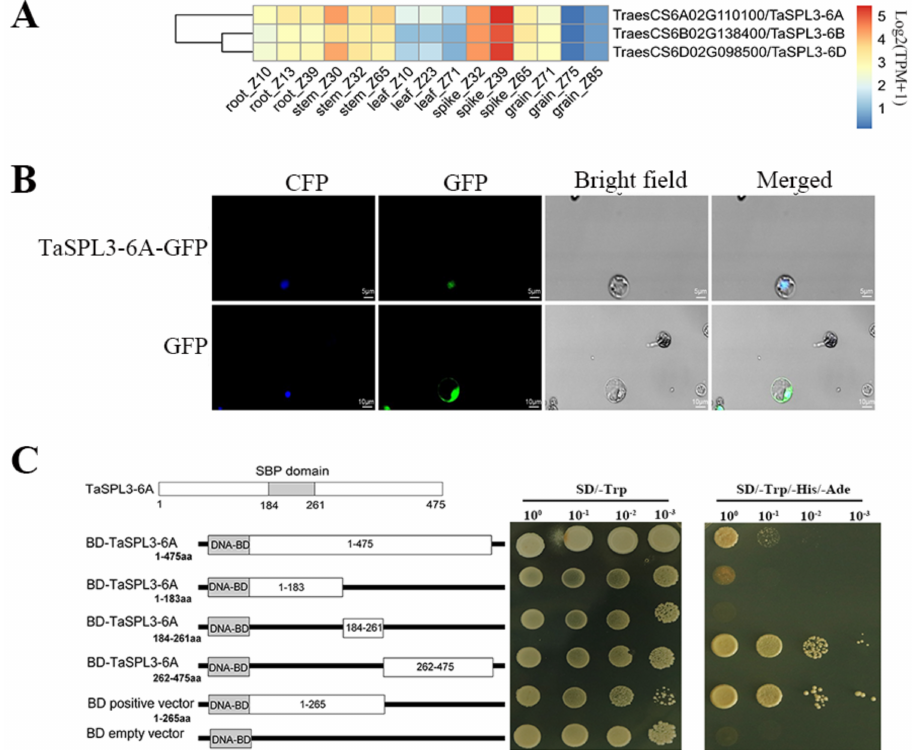
Figure 5. Characterization of the TaSPL3 expression patterns ( A ), sub-cellular localization ( B ), and transactivation ability ( C ). ( A ) RNA-seq analysis demonstrates that all of the three TaSPL3 homeolo- gous genes are highly expressed in spike tissues, followed by stem and developing grain tissues; ( B ) a sub-cellular localization assay was performed in isolated rice protoplasts with transient expression of TaSPL3-6A gene fused with GFP . CFP is a marker plasmid with nuclear localization as positive control; and ( C ) transcription activity analysis of TaSPL3-6A. In the left panel, the schematic diagram shows that the TaSPL3-6A protein is separated into three parts by the SBP domain (from 184 to 261 amino acid residues). In addition, the left panel shows a series of TaSPL3-6A full-length and truncated pro- teins that were constructed on the pGBKT7 vector, respectively, to identify the region of TaSPL3 with transactivation ability. In the right panel, the yeast colonies with four different gradients, 10 − 1 , 10 − 2 , 10 − 3 , 10 − 4 , were plated on the screening medium SD/ − Trp and SD/ − Trp/ − His/ − Ade, respec- tively. The empty pGBKT7 vector and positive vector were used as the negative and positive controls, respectively. SD: Synthetic dropout medium; SD/ − Trp: Trp-defective SD; SD/ − Trp/ − Ade/ − His: Trp-, Ade-, and His-defective